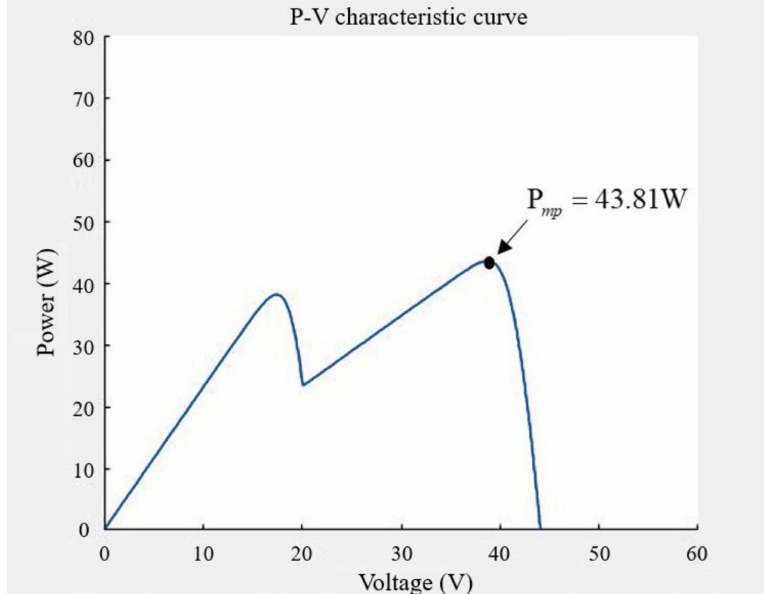
Figure 14. P–V characteristic curve simulation for Case 6.